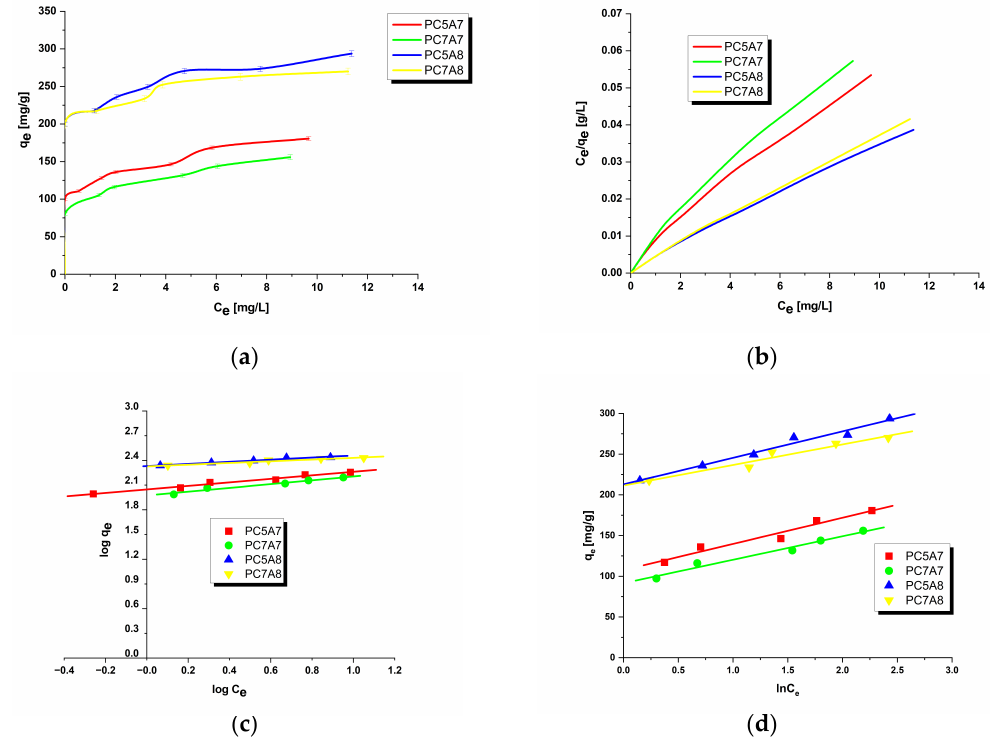
Figure 4. Adsorption of crystal violet onto activated carbons ( a ) equilibrium adsorption of the dye, ( b ) Langmuir isotherm plots, ( c ) Freundlich isotherm plots and ( d ) Temkin isotherm plots.